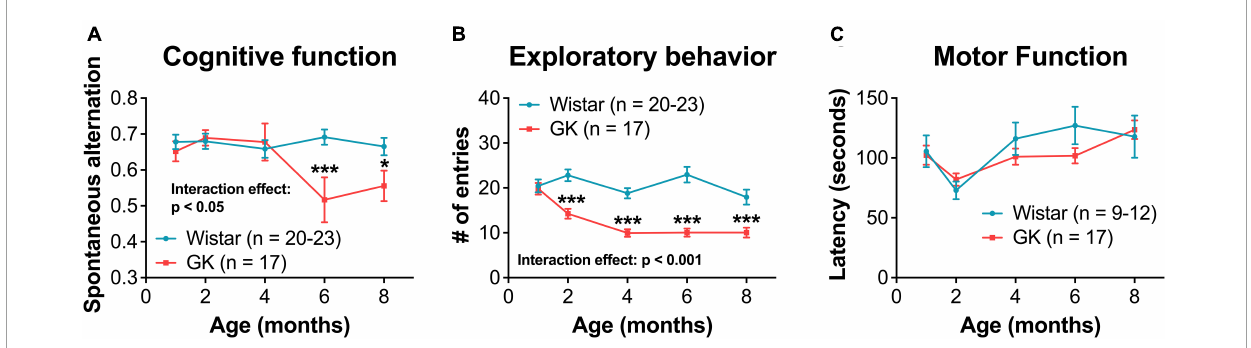
FIGURE5 Goto-Kakizaki rats exhibit cognitive and exploratory behavior deficits, but not motor function deficits. (A) Cognitive function at 1, 2, 4, 6, and 8 months of age as measured by spontaneous alternation on Y-maze. (B) Exploratory behavior at 1, 2, 4, 6, and 8 months of age as measured by # of entries on Y-maze. (C) Motor coordination as measured by rotarod latency. * p < 0.05, *** p < 0.001. Results expressed as mean ± SEM.